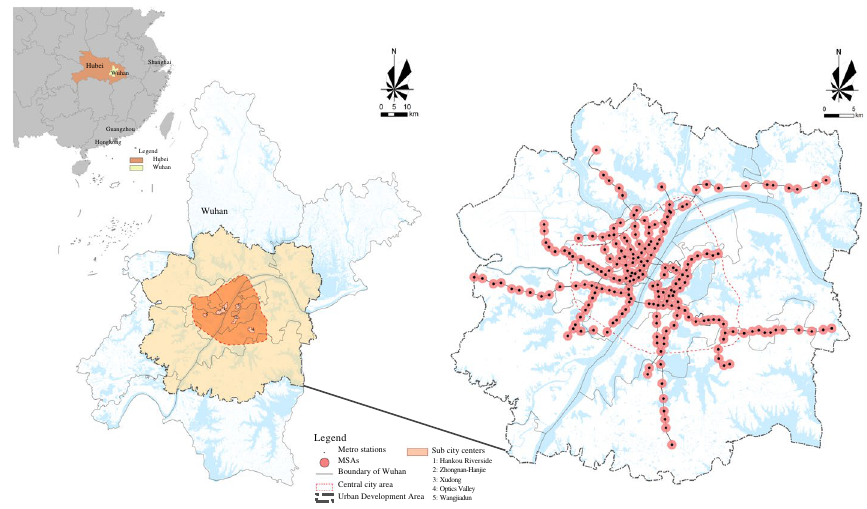
Fig. 2 Study area in Wuhan, China